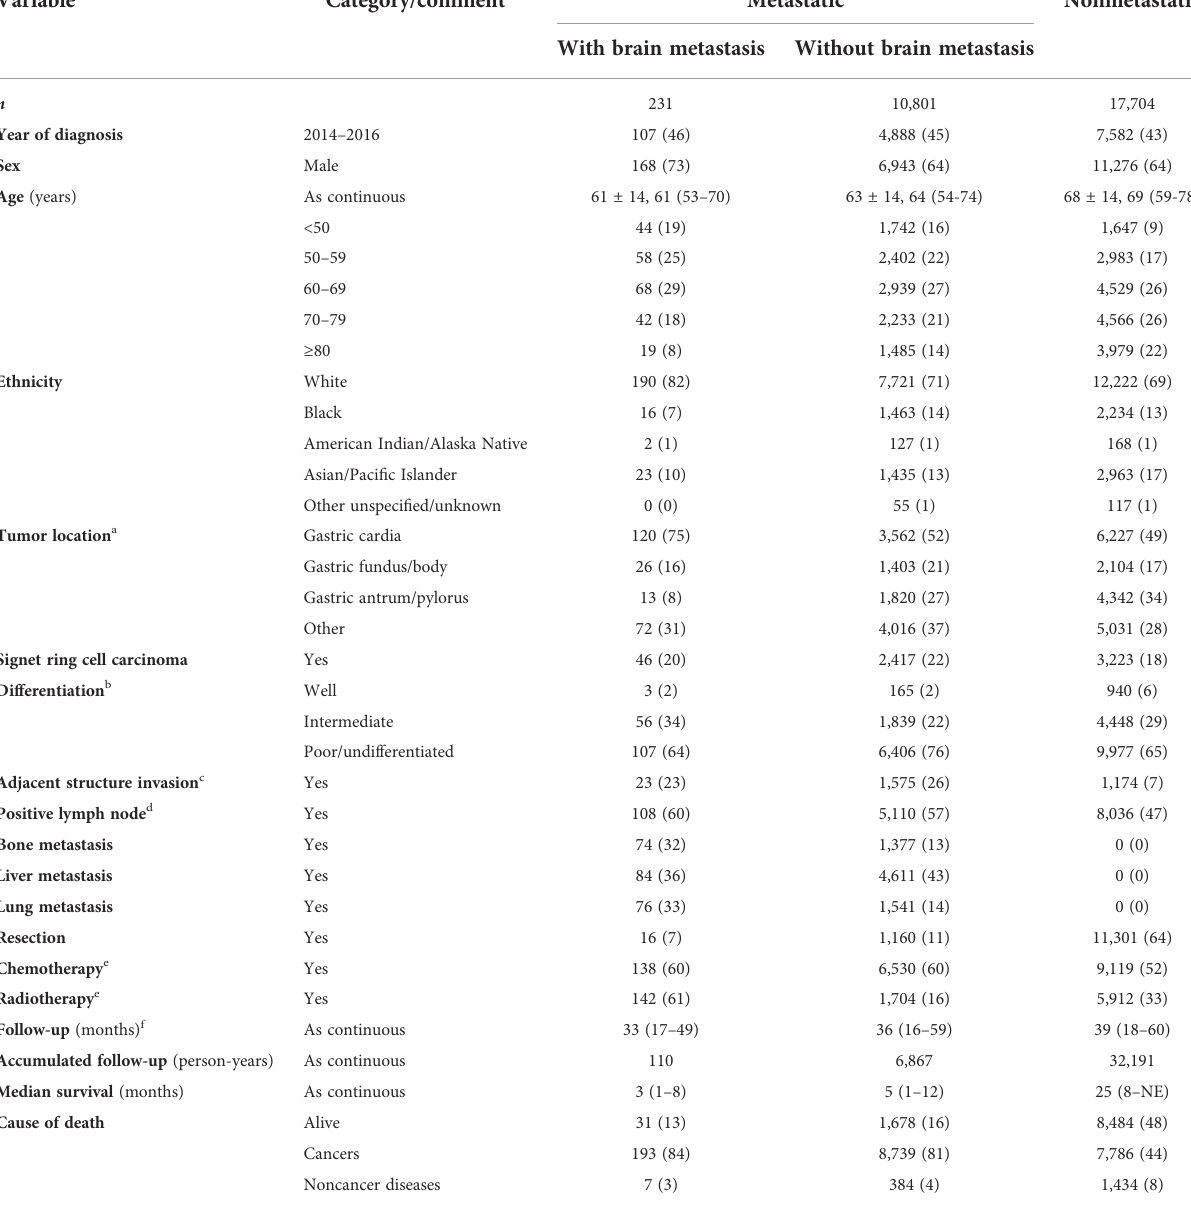
TABLE 1 Baselinefeaturesof cases withmetastatic(withandwithoutbraininvolvement)andnonmetastaticgastricadenocarcinoma,2010